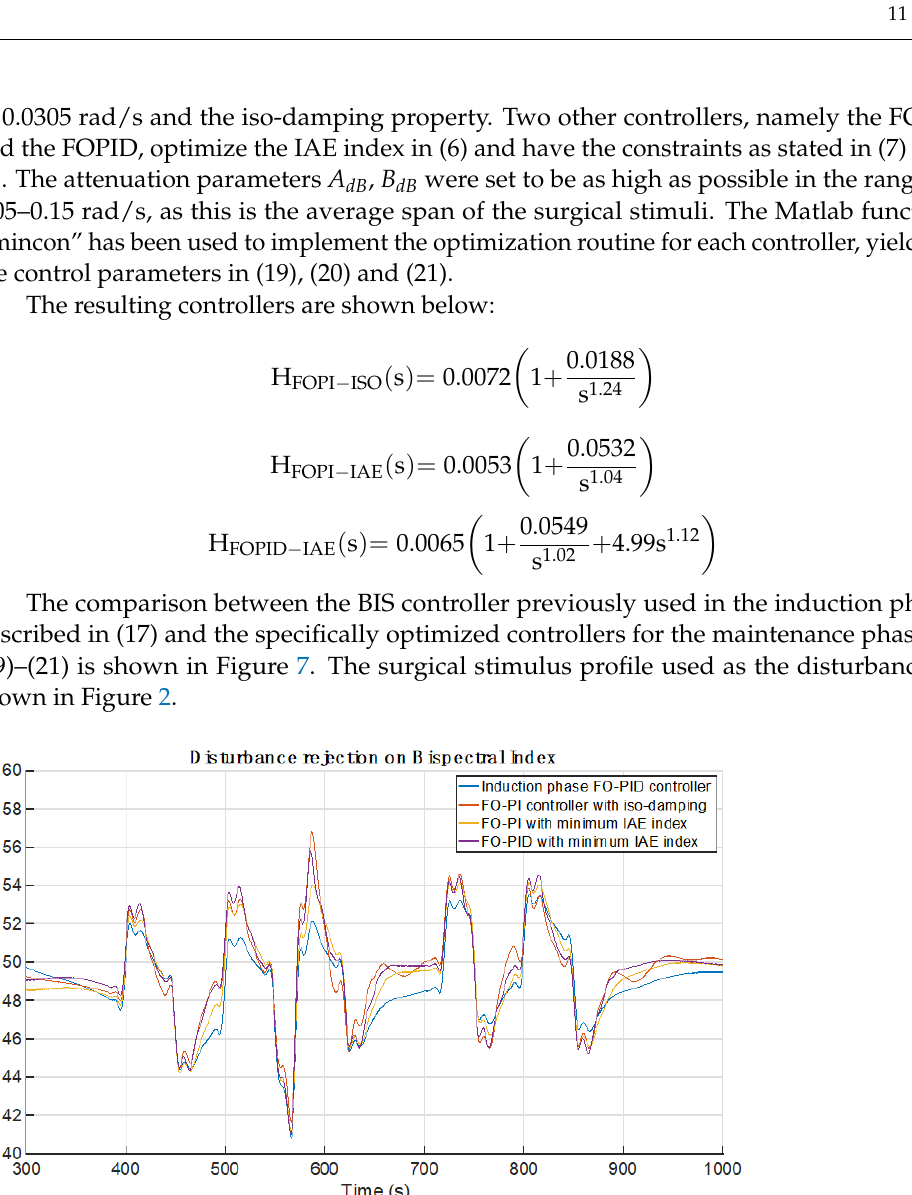
Table 3. Numerical performance comparison of the optimized controllers.